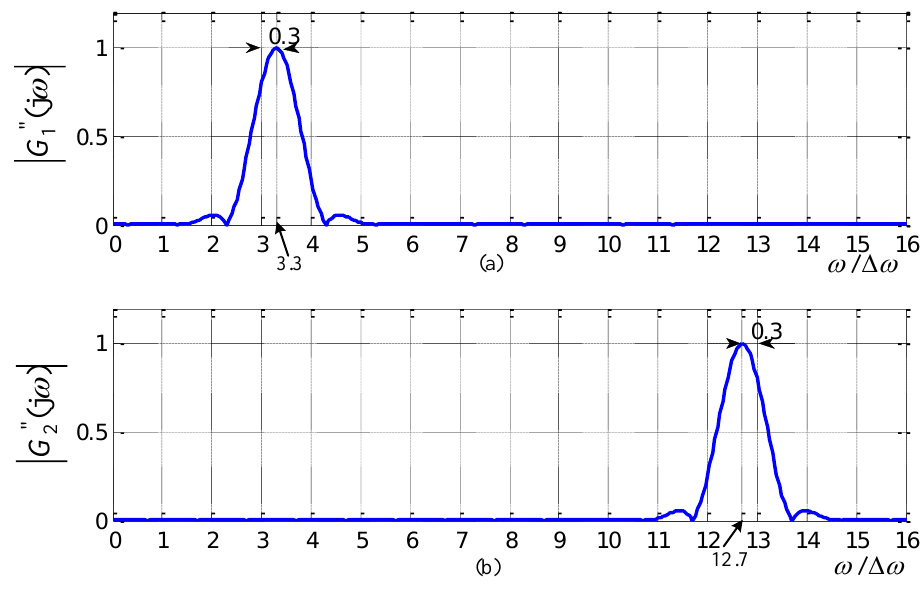
; ( b ) sub-filter g (cid:48)(cid:48) . 2 1 ( j ω ) | are exactly ( j ω ) | , | G (cid:48)(cid:48) 2 1